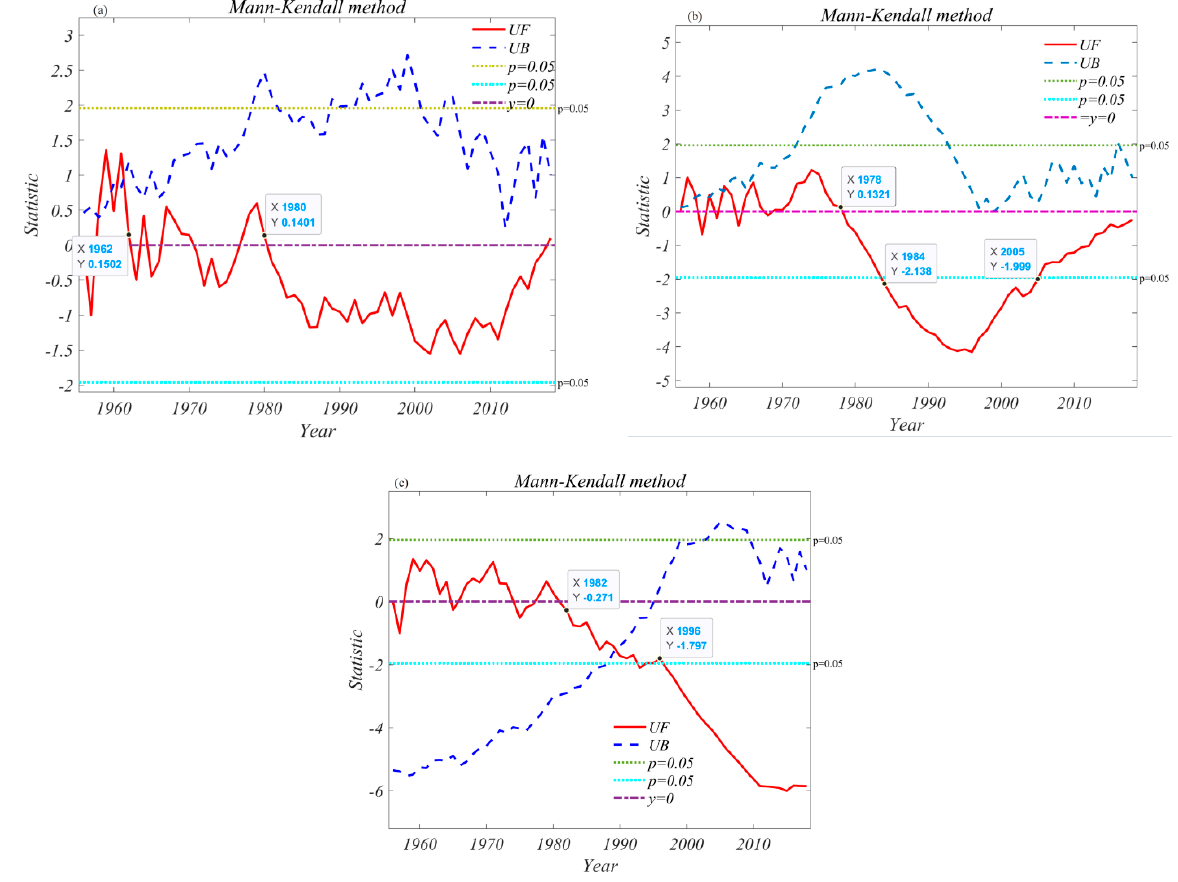
Figure 2. Mann–Kendall (MK) trend test of the ( a ) annual precipitation, ( b ) potential evapotranspiration, ( c ) runoff depth. UF, UB, and p are the statistics in the Mann–Kendall trend test, respectively.